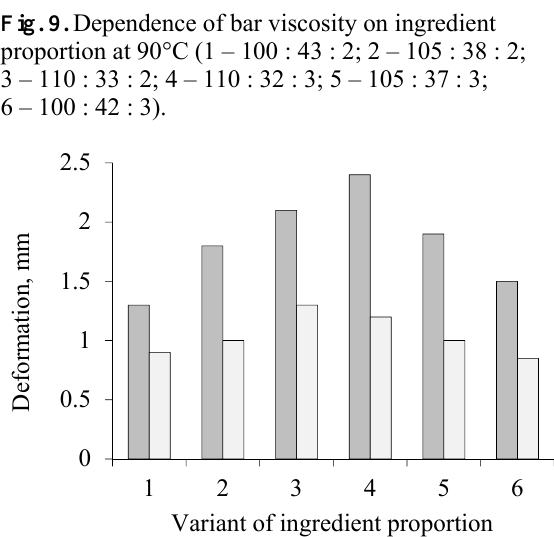
Variant of ingredient Fig. 12. Dependence of hardness of bar mixture at different ingredient proportions (1 – 100 : 43 : 2; 2 – 37 : 3; 6 – 100 : 42 : 3).